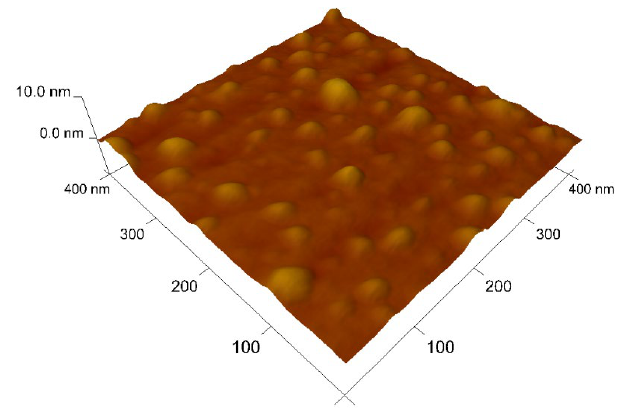
Figure 5. AFM image of TiP-CD.